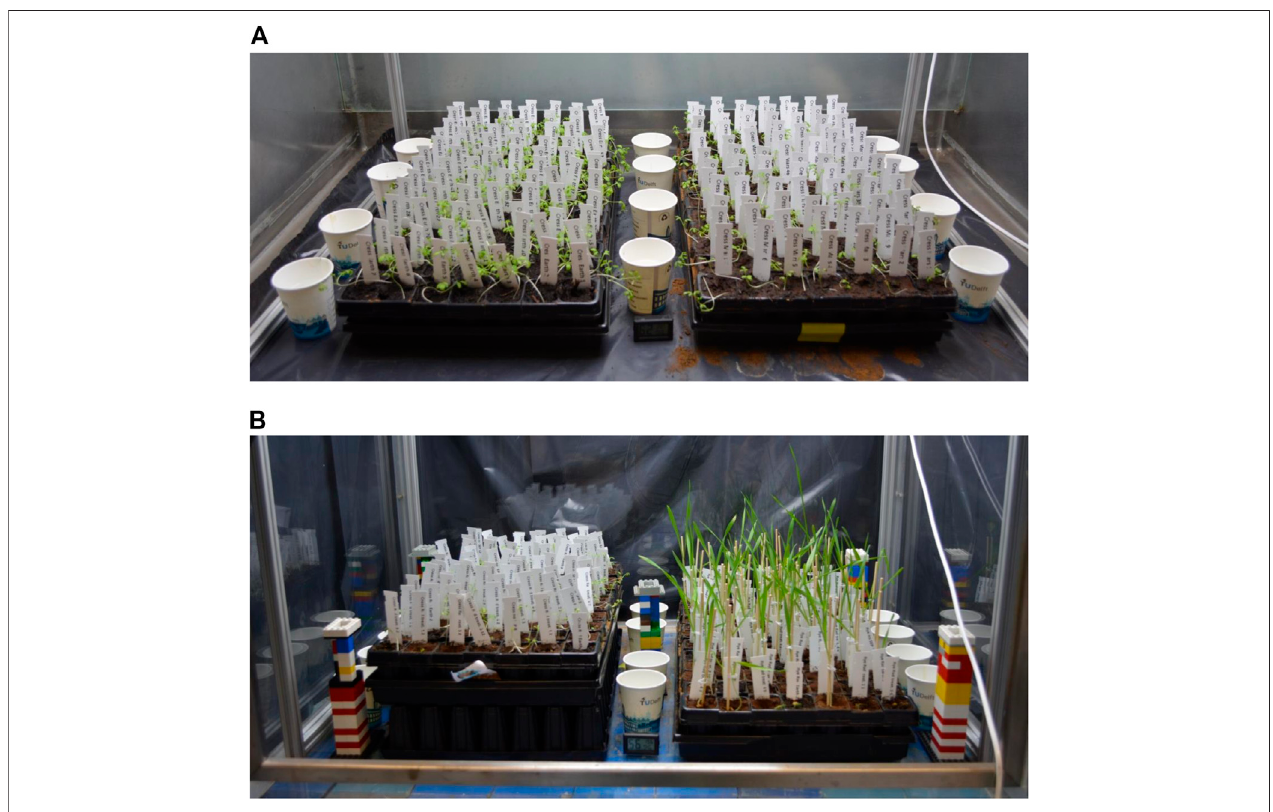
FIGURE 1 | (A) sowing the cress control Earth (CE, left) and control Mars (CM, right). Shown are the pots with trays, the water cups and the temperature and humidity meter located in between the two trays. (B) is showing the radiation treatments in the radiation fume hood surrounded by lead walls. Treatments of cress (left) and rye (right) are indicated with white labels. Lego towers hold thermoluminescent dosimetry (TLD) cups at the top. Pictures were taken on the morning of